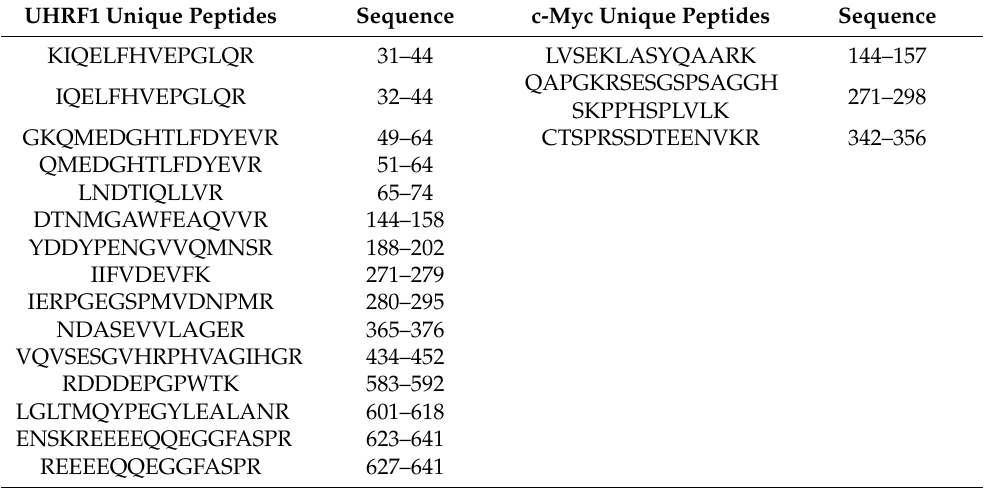
Table A3. Peptides identified by LCMS, following co-IP with anti-UHRF1 antibody from REH